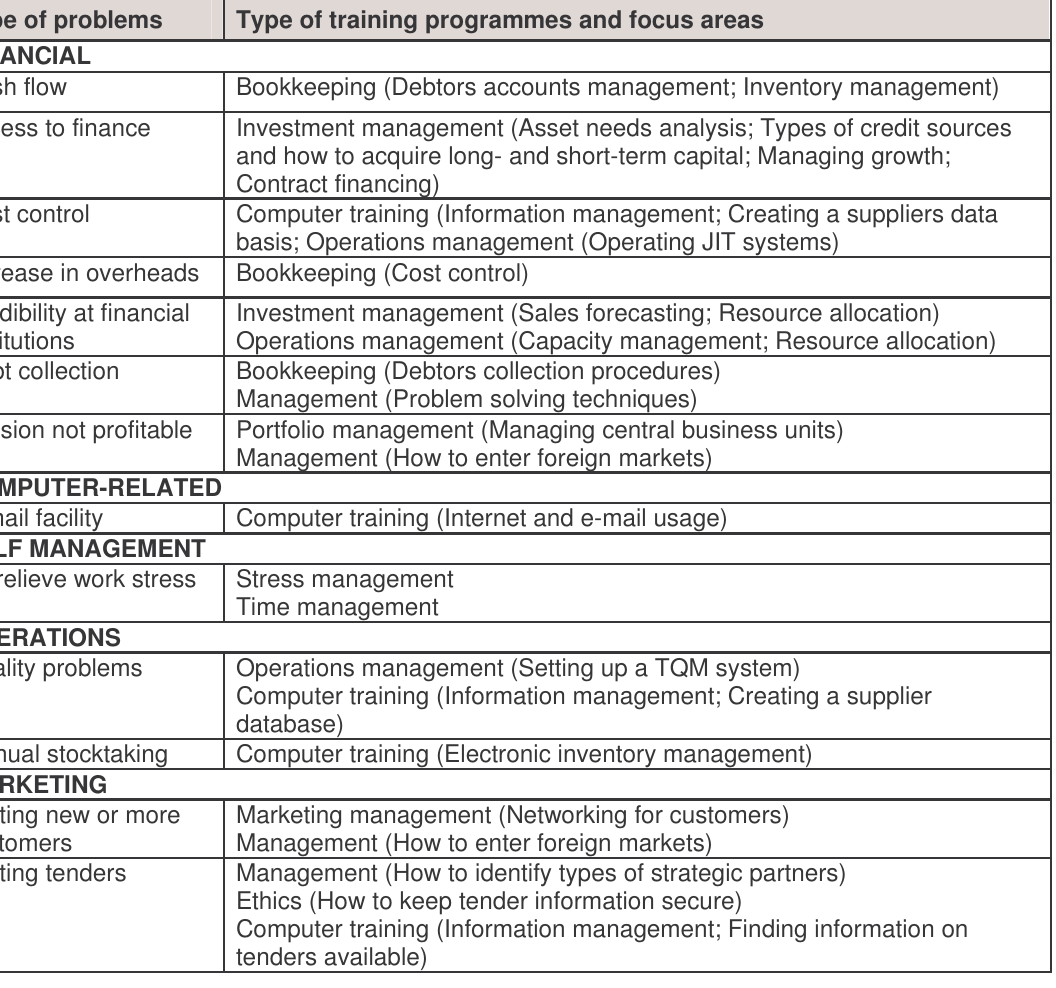
Table 2:Results of the training needs of participants Type of